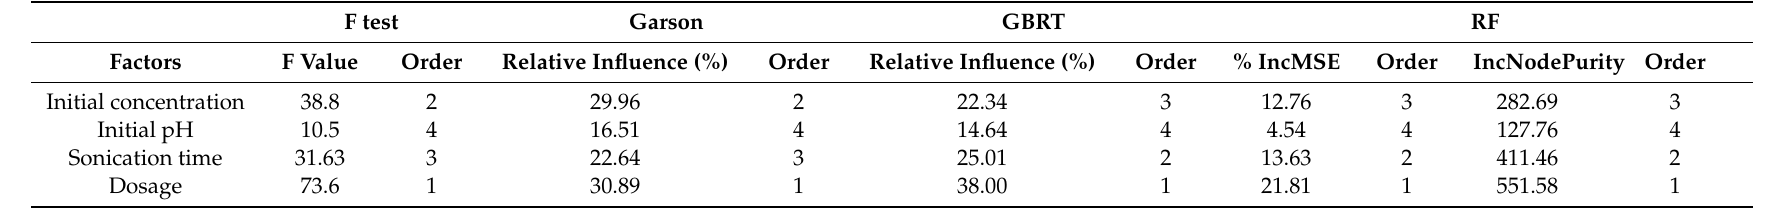
Table 6. Comparison among F value, Garson method, GBRT and RF of factors